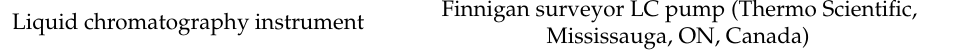
Table 1. The summary of analysis of CIP via LC-MS/MS. Liquid chromatography